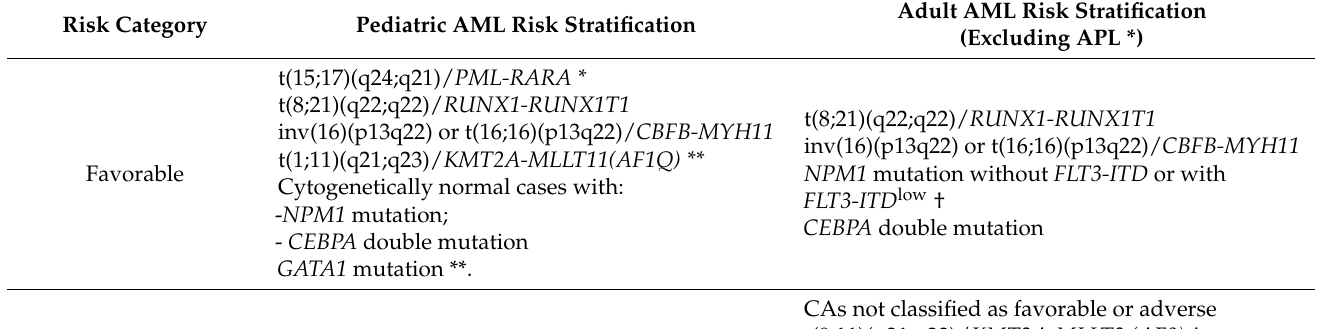
Table 3. Pediatric and Adult AML cytogenomic risk stratification according to and adapted from Creutzig et al. [1] and Döhner et al. [21],